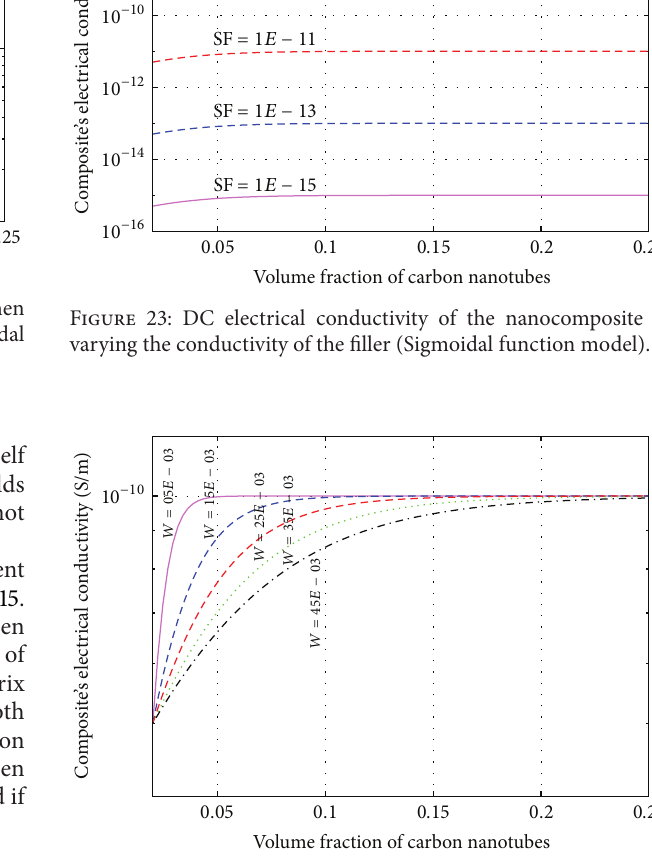
Figure 24: DC electrical conductivity of the nanocomposite when the width of the percolation region is varied (Sigmoidal function